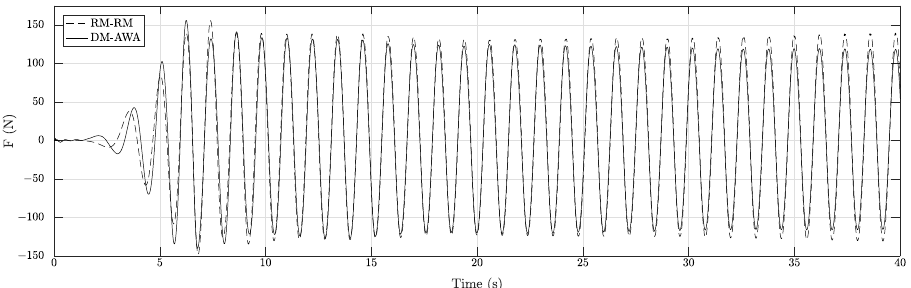
Figure 10. Wave forces measured on the cylinder using the combinations DM-AWA and RM-RM for wave generation and absorption for H = 0.1 m and L = 2 m.